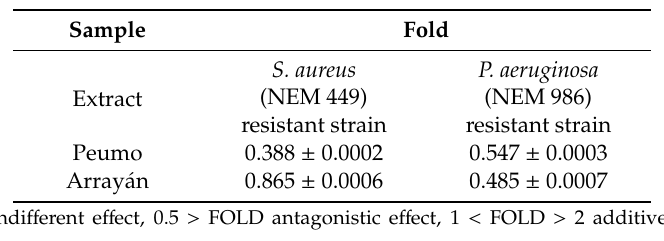
Table 2. Modulation of the drug-resistant phenotype in bacteria by arrayan and peumo extract. The fold is expressed as a ratio of IC 50 of antibiotics and IC 50 of antibiotics with the addition of extract at IC 25